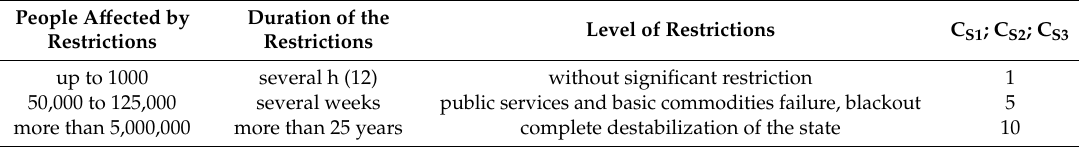
Table 6. Social consequences coe ffi cient.